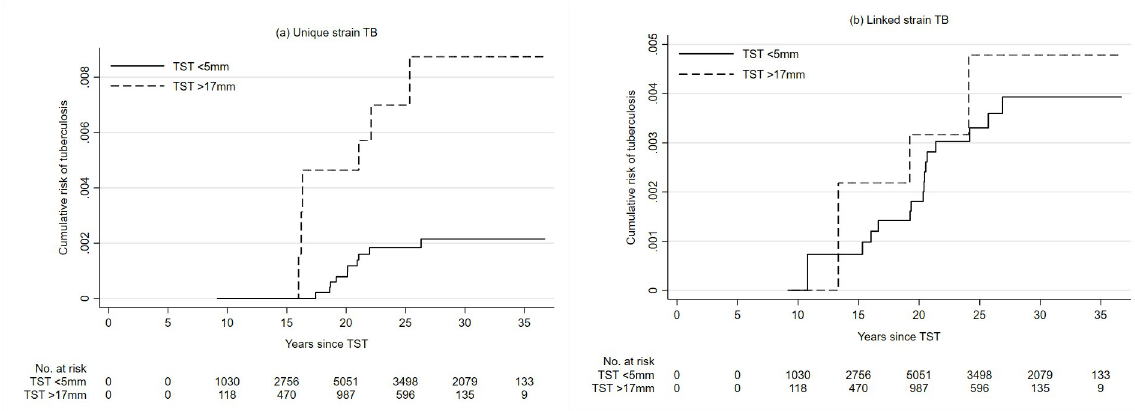
Fig 2. a: Cumulative risk of unique strain tuberculosis after 1998, by time since tuberculin skin test and induration size. b: Cumulative risk of linked strain tuberculosis after 1998, by time since tuberculin skin test and induration size.